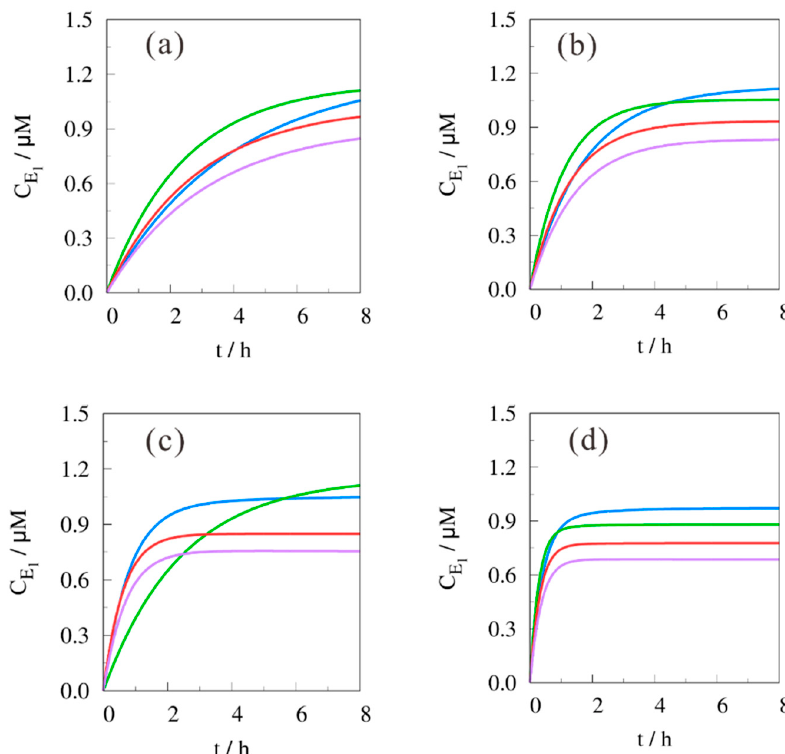
Figure 1. Concentration of jasmin aldehyde ( E 1 ) as a function of reaction time. ( B / H ) 0 = 2 mol · mol − 1 , T = ( a ) 80 °C, ( b ) 100 °C, ( c ) 120 °C, ( d ) 140 °C; ( ─ ) methanol, ( ─ ) ethanol, ( ─ ) n-propanol, ( ─ ) n-butanol. Lines are obtained as described in Section 3.2.